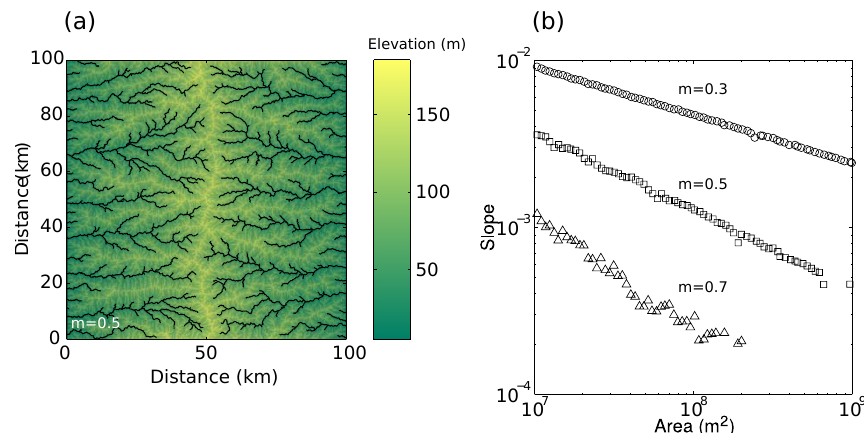
Figure 5. (a) Steady-state topography after 10Myr for the transport model in which m = 0 . 5 and k = 10 − 5 m − 1 (m 2 yr − 1 ) 1 − m . (b) Slope– area relationship for the transport model for m = 0 . 3, 0.5, and 0.7.